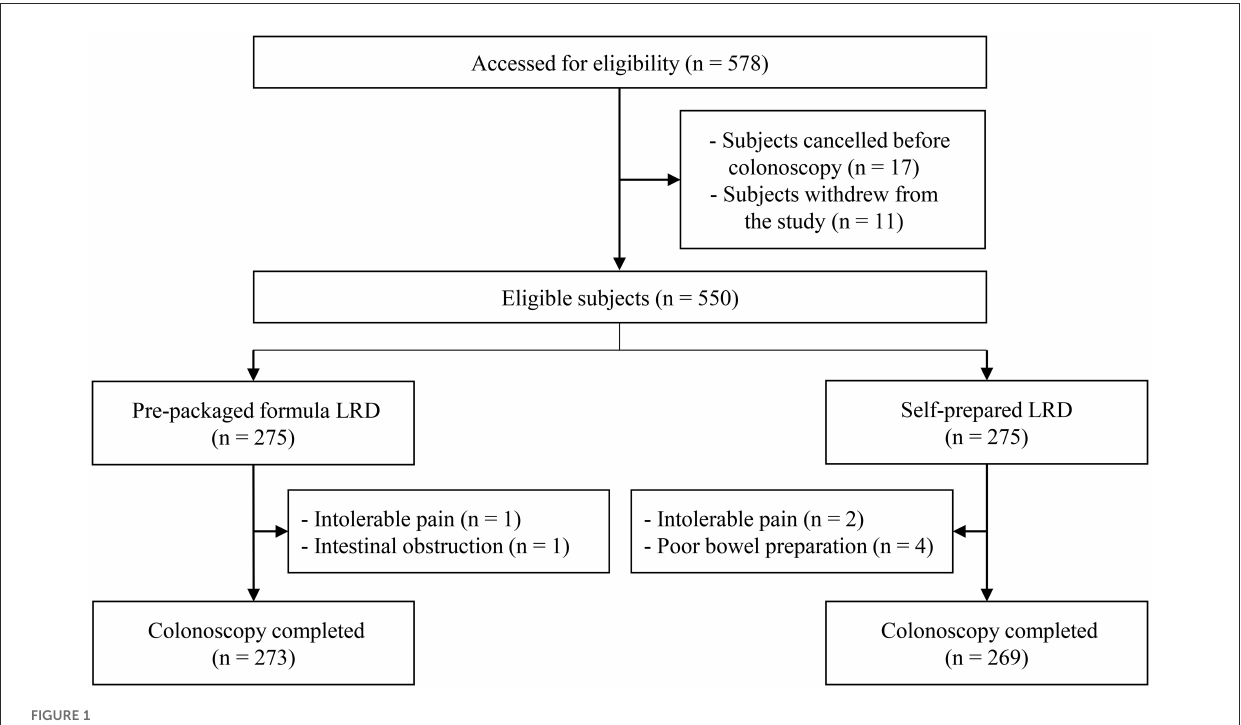
FIGURE1 Study flow diagram. LRD, low-residue